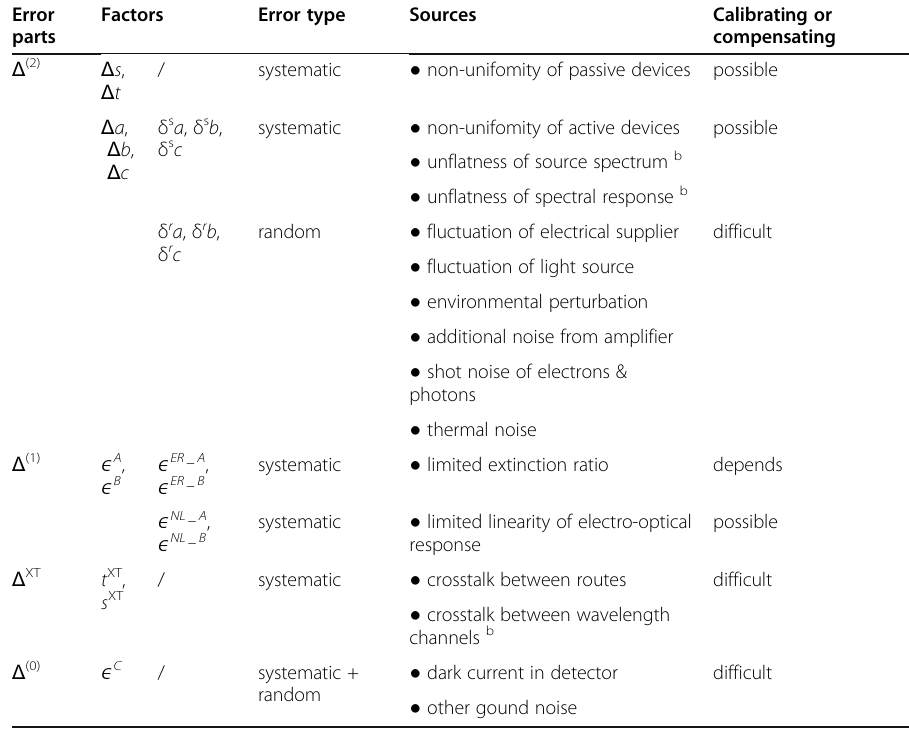
Table 3 Classification and sources of error parts in OPU a Error